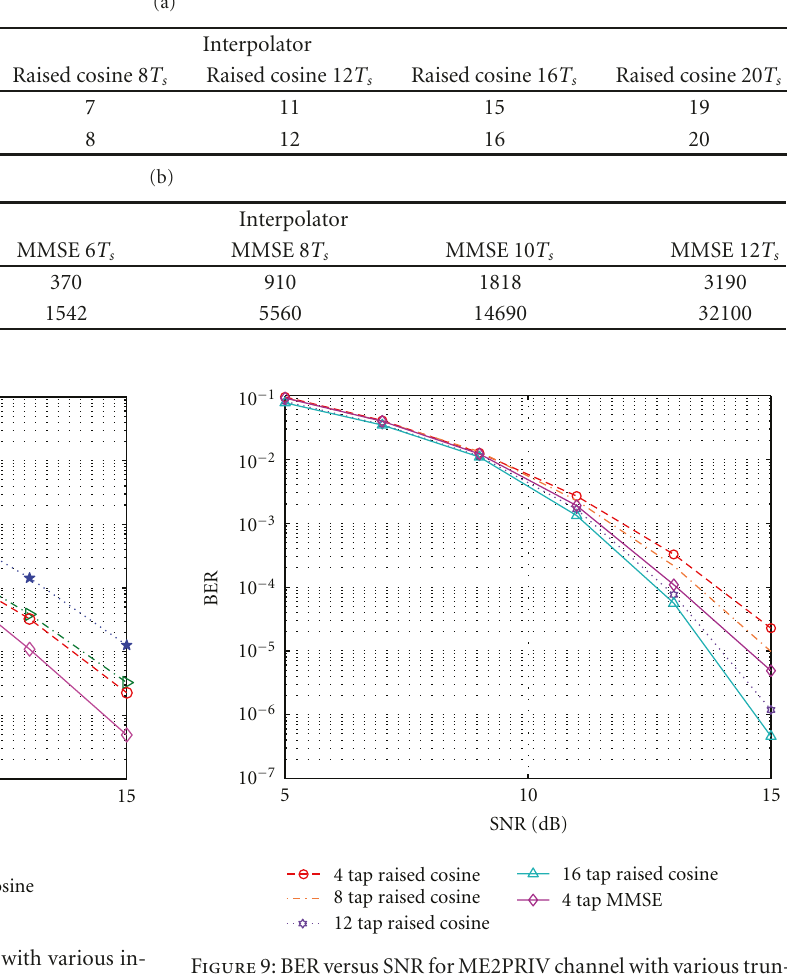
Figure 9: BER versus SNR forME2PRIV channel withvarious trun- cation